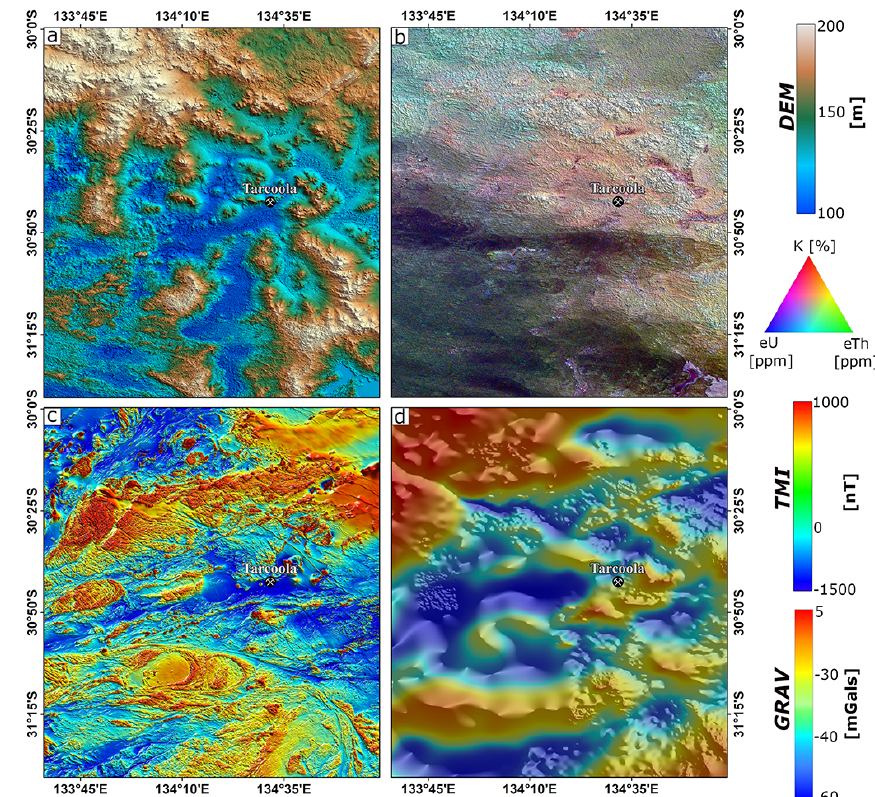
Figure 5. (a) Colour digital elevation model (laser altimeter) (min: 84.08m; max: 365.33ma . s . l . ), (b) colour radiometric dose rate (NASVD corrected) (min: 0.074nGyh − 1 ; max: 239.30nGyh − 1 ), (c) colour total magnetic intensity (reduced to pole) (min: − 1978 . 16nT; max: 21638.8nT), and (d) colour and hill-shaded Bouguer gravity anomaly image (Katona, 2017) (min: − 158 . 15mGal; max: 64.74mGal). Data source: GCAS Region 9A, https://map.sarig.sa.gov.au/.